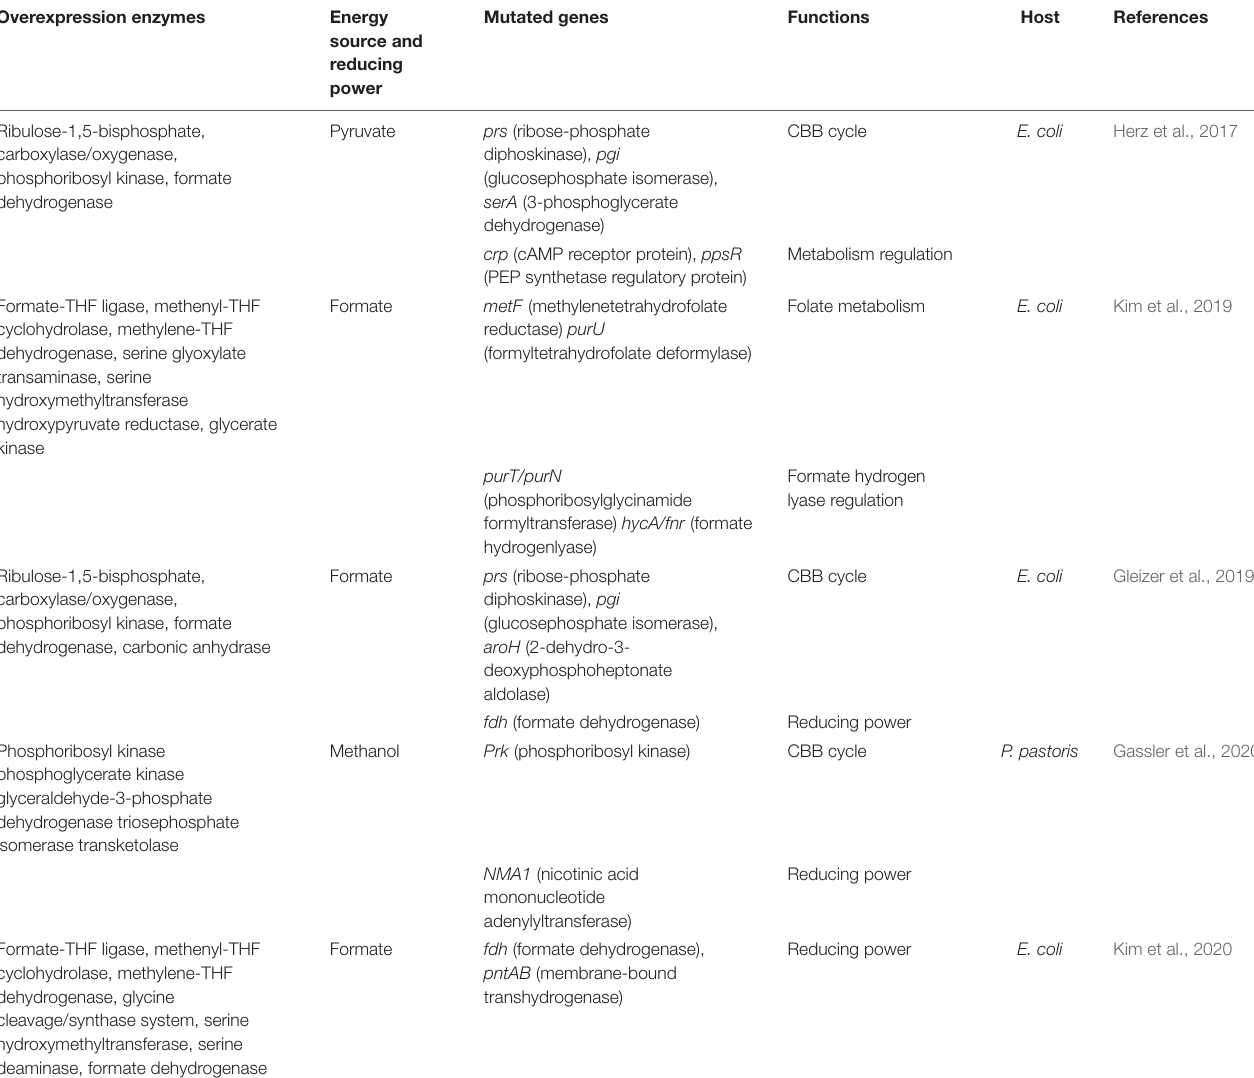
TABLE 2 | Essential mutations for adaptation to